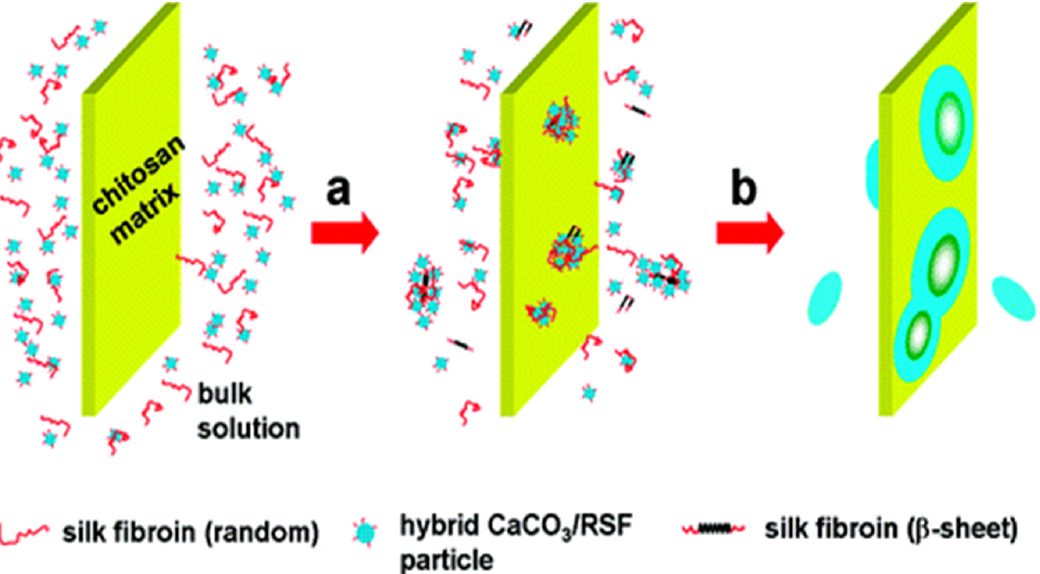
Figure 16. Mechanism of the formation of disk-like CaCO 3 : ( a ) nucleation of CaCO 3 due to the adsorption of RSF and CaCO 3 /RSF hybrid nanoparticles; ( b ) accumulation of CaCO 3 /RSF hybrid nanoparticles inducing growth of the disk-like crystals. The figure is adapted with permission from [68].